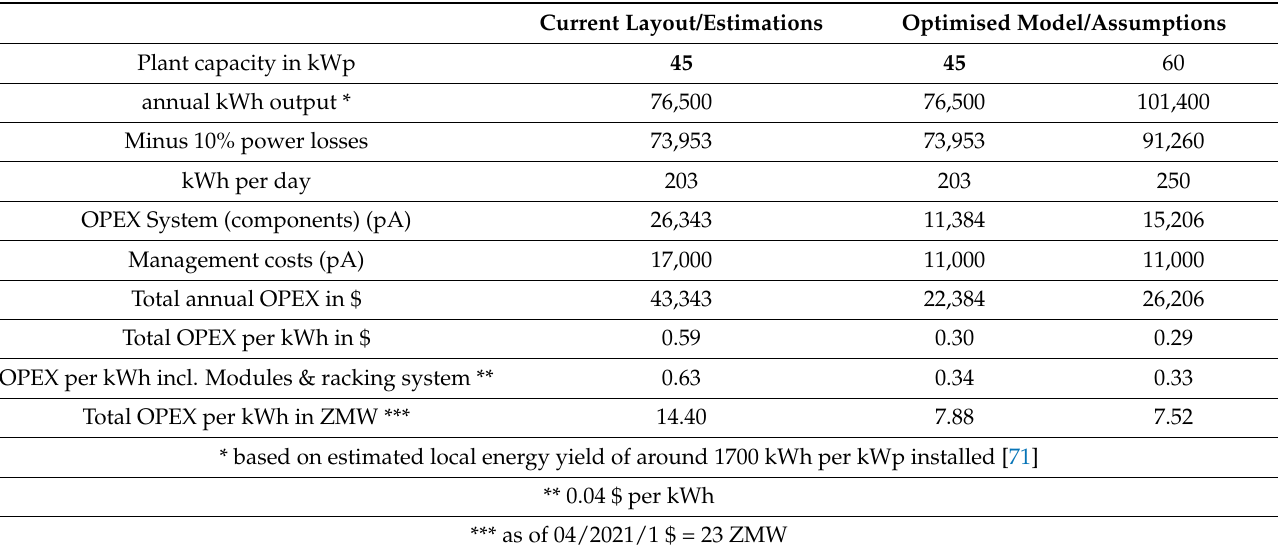
Table 5. Current and optimised OPEX for Mpanta